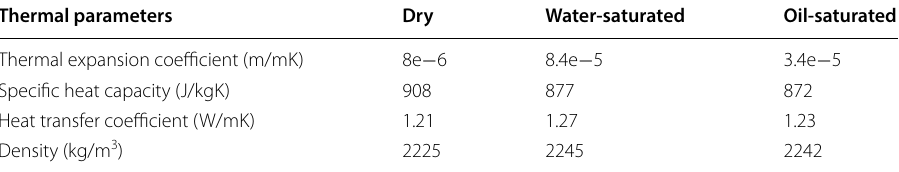
Table 3 Thermal parameters of limestone Thermal